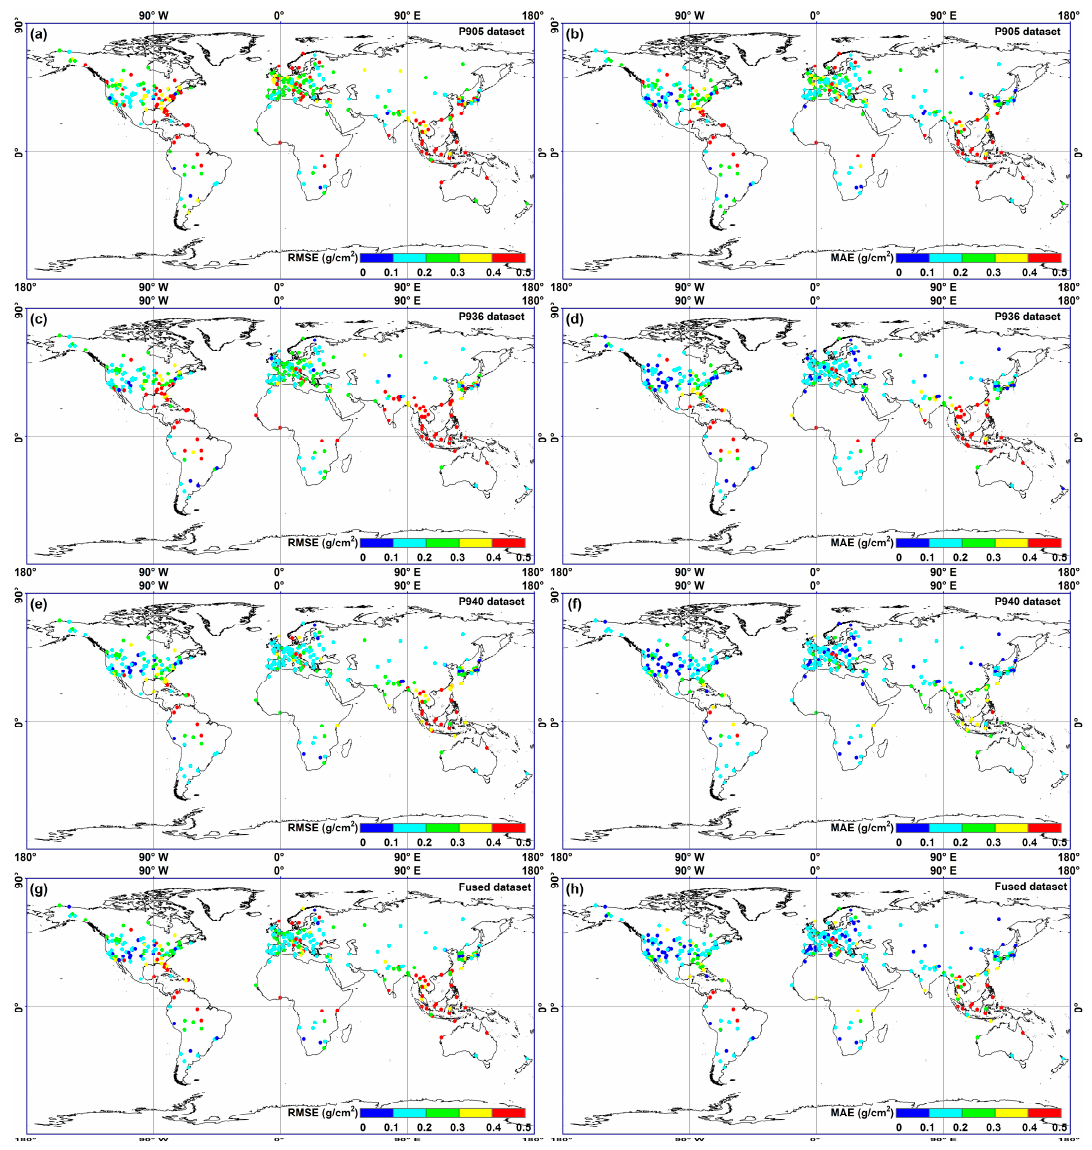
Figure 6. Spatial distribution of RMSE and MAE for the four MERSI-2 PWV datasets. ( a ) RMSE of the P905 dataset; ( b ) MAE of the P905 dataset; ( c ) RMSE of the P936 dataset; ( d ) MAE of the P936 dataset; ( e ) RMSE of the P940 dataset; ( f ) MAE of the P940 dataset; ( g ) RMSE of the fused dataset; ( h ) MAE of the fused dataset.